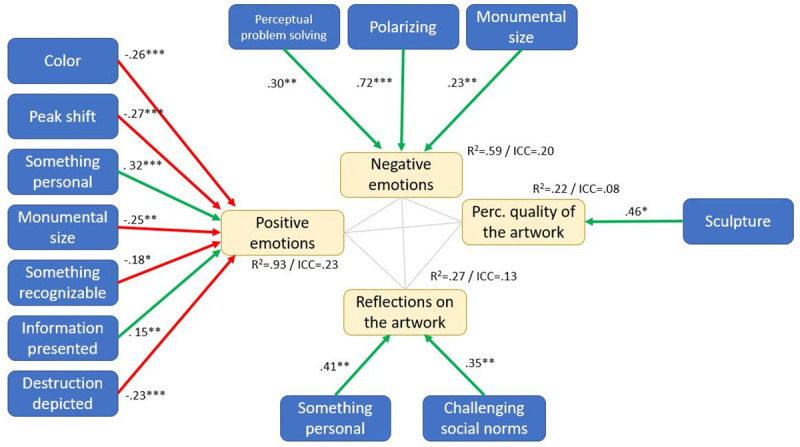
Artwork level part of the multilevel model with variance in emotional responses, identification with the artist, perceived quality of the artwork, and reflection on the artwork modeled on the artwork level (Nlevel1 = 714, Nlevel2 = 30).